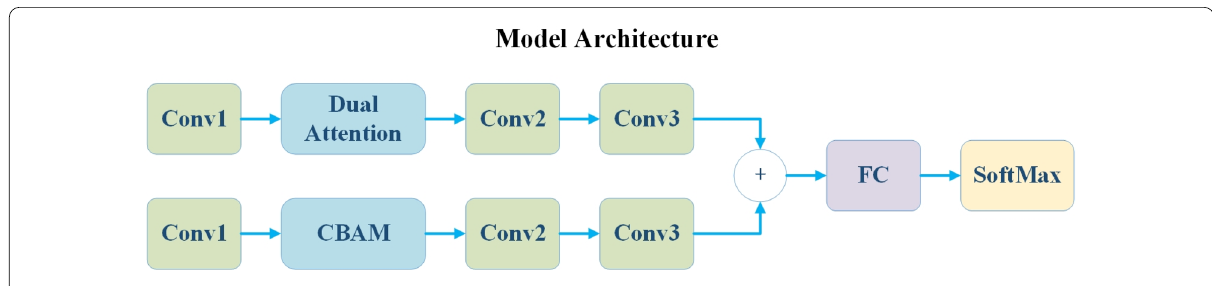
Figure 2 The Model Architecture of